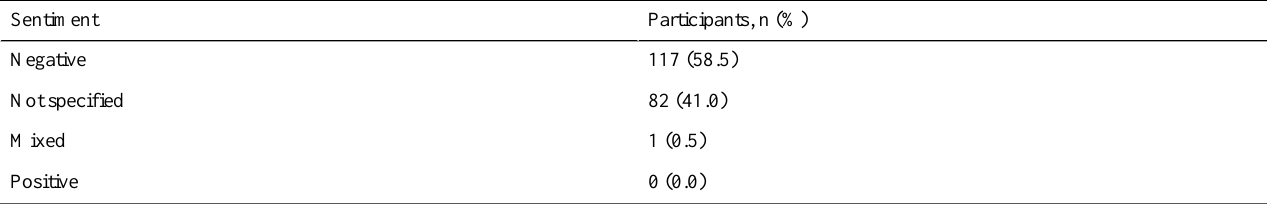
Table 5. Sentiment